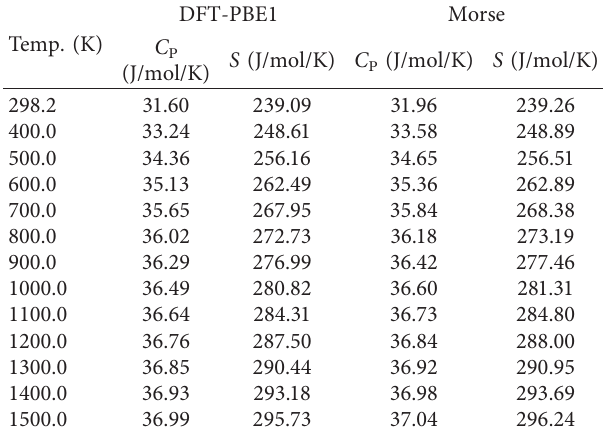
Table 2: Entropy and heat capacity of UC.